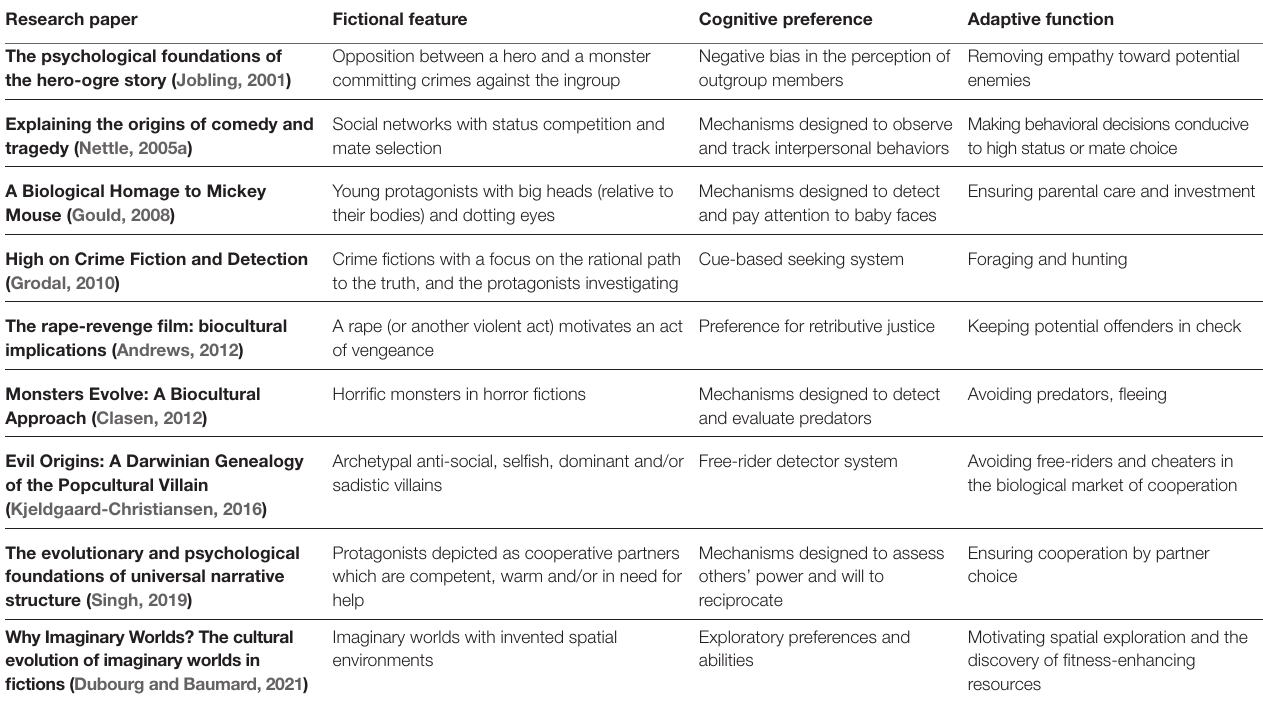
TABLE 1 | Research papers explaining the appeal of fictions by linking fictional traits with the cognitive mechanisms they co-opt, and the evolutionary function of the